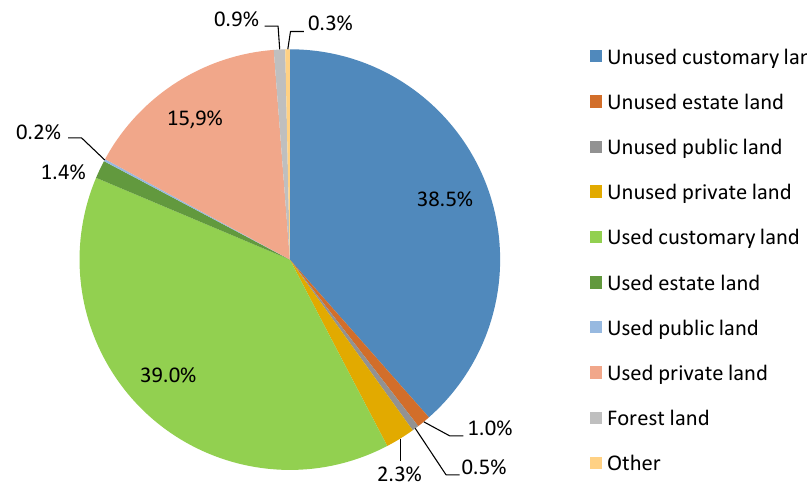
Figure 9. Prior land use and land tenure of lands acquired by medium-scale farms, Kasungu, Lilongwe, and Mchinji districts (in percentage) ( N = 300). Source: Authors’ medium-scale farm survey in the Mchinji, Kasungu and Lilongwe Districts undertaken by LUANAR, UP, and MSU (2014–2015).